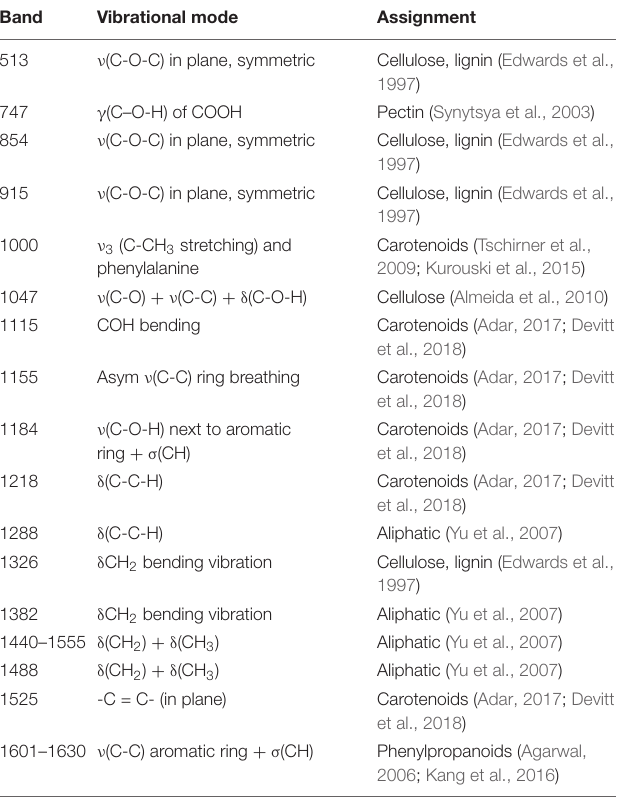
TABLE 2 | Vibrational bands and their assignments for spectra collected from peanut